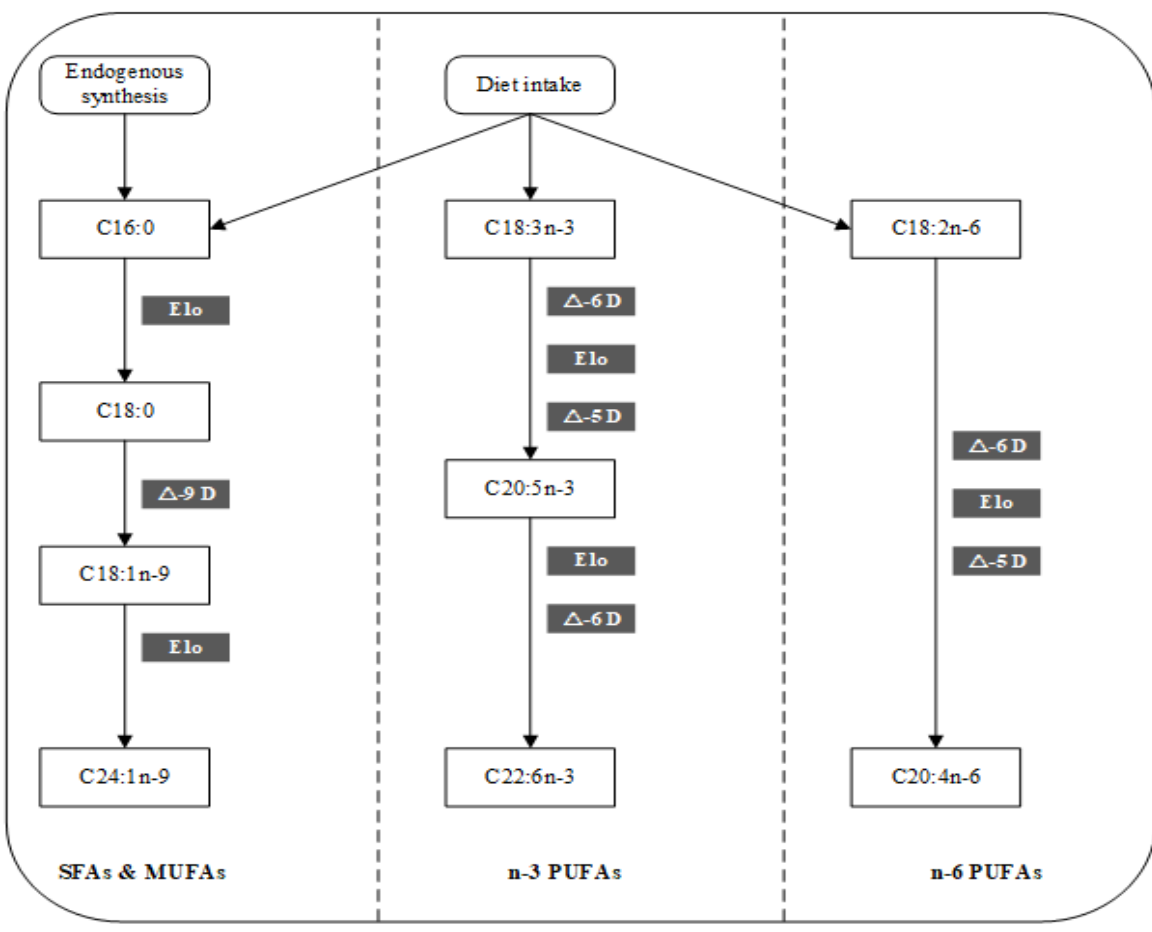
Figure 4. Pathways of main fatty acid metabolism. Abbreviations: SFAs—saturated fatty acids; MUFAs—monounsaturated fatty acids; PUFAs—polyunsaturated fatty acids; Elo—elongase; D— desaturase. Table 5. Partial correlation coefficients of mineral elements with several indices of desaturases and elongases in erythrocyte among children.